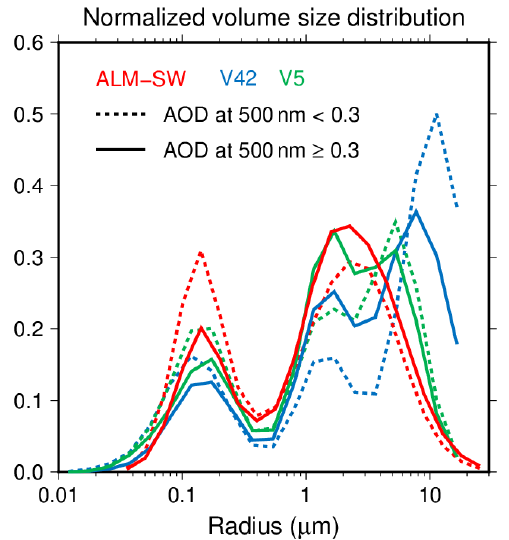
Figure 11. Means of normalized volume size distributions of the ALM-SW (red), V42 (blue), and V5 (green) for the data on aerosol optical depth at 500nm more than 0.3 (thick lines) and less than 0.3 (broken